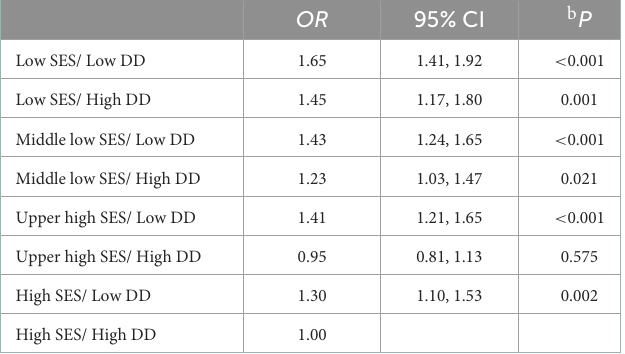
TABLE 2 Combined association of SES and DD on HRQoL according to the EQ-5D disutility score a ( N = 3,250). OR 95% CI b